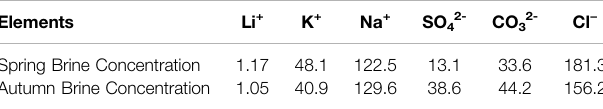
TABLE 1 | The main chemical composition of Zabuye salt lake brines